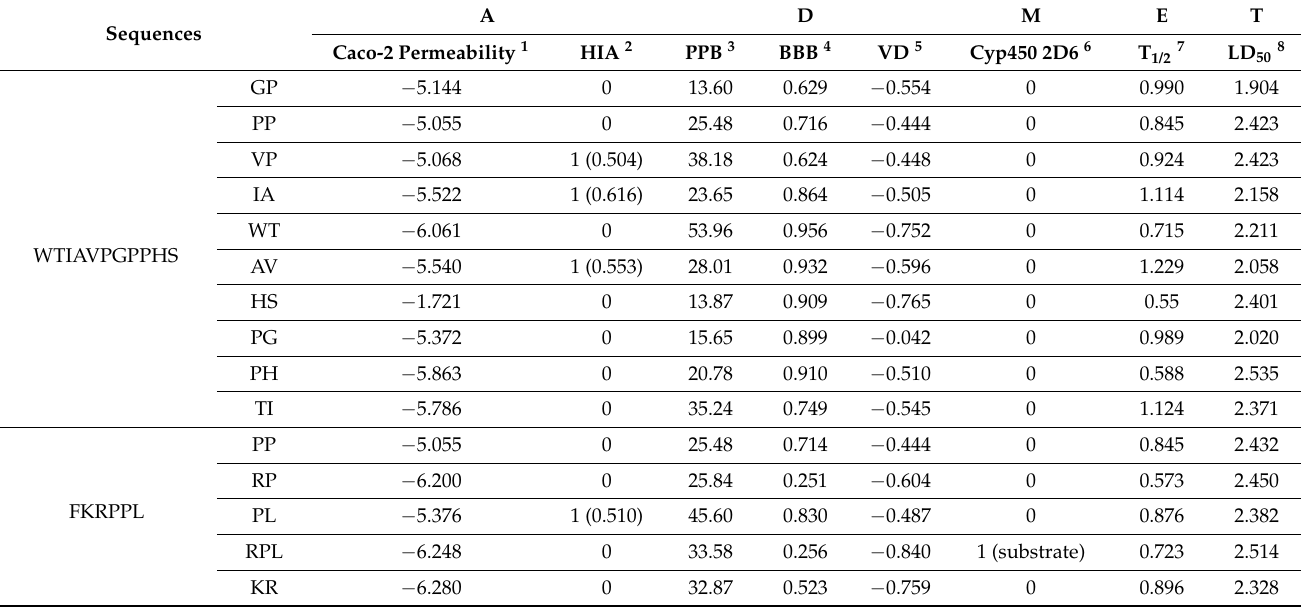
Table 5. ADMET profile of the test ligand acting as DPP-IV